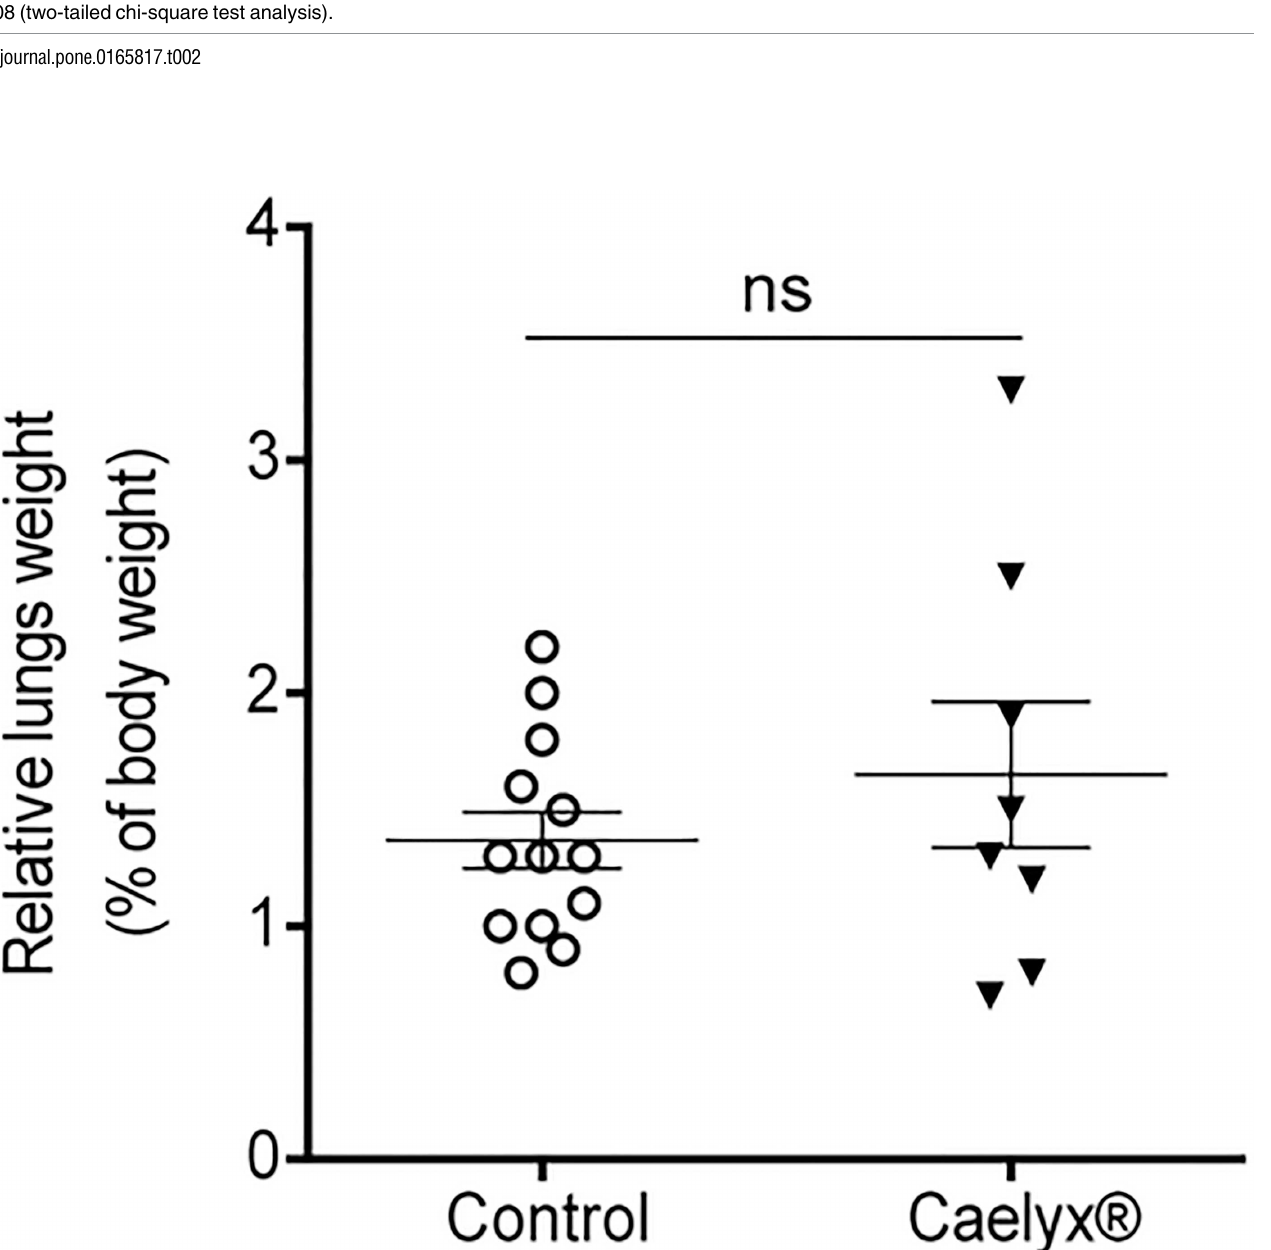
Table 2. Incidence of metastatic lesions in 4T1 breast carcinoma-bearing mice. No. of mice with metastatic lesions /total no. of mice analyzed (%) Lungs Liver Pancreas Mesentery Diaphragm Control 13/13 (100%) 2/13 (15%) 9/13 (69%) 10/13 (77%) 6/13 (46%) Caelyx ® 6/8 (75%) a 0/8 (0%) 4/8 (50%) 3/8 (38%) b 2/8 (25%) a , p = 0.0581. b , p = 0.0708 (two-tailed chi-square test analysis).